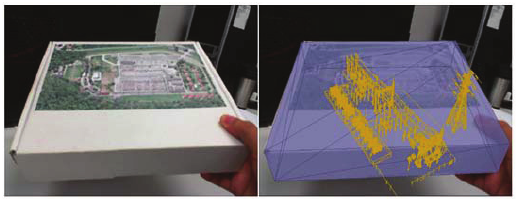
Figure 3. Augmented reality prototype.